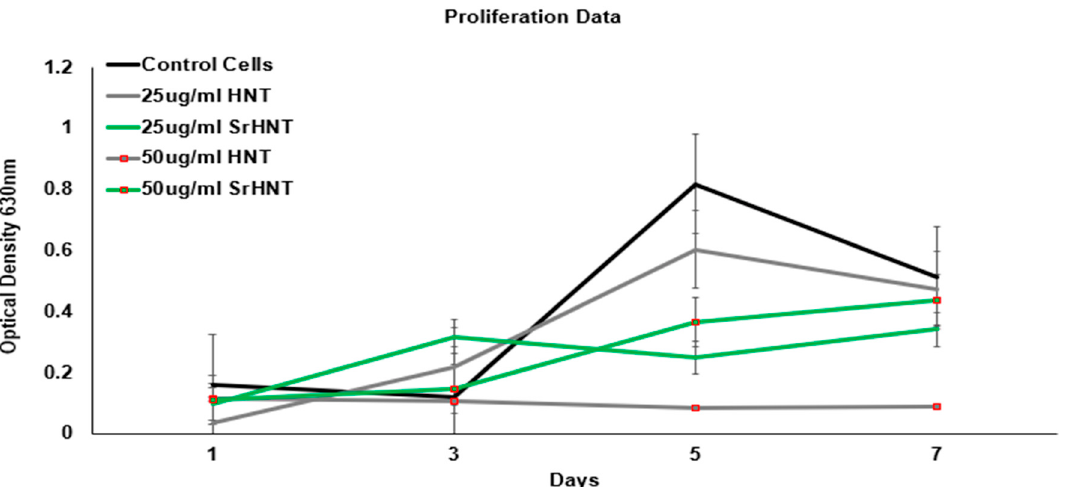
Figure 8. Graph showing proliferation of pre-osteoblast cells after exposure to two different concen- trations of 25 and 50 μ g/mL of HNT and SrHNT for days 1, 3, 5, and 7. Grey and green lines depict HNT and SrHNT, respectively. Marked lines represent high concentration lines. Error bars are standard deviations where n = 3.